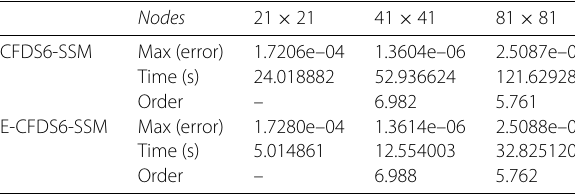
Table 4 The convergence order and computational time for SP 2 at t = 2 Nodes 21 × 21 41 ×